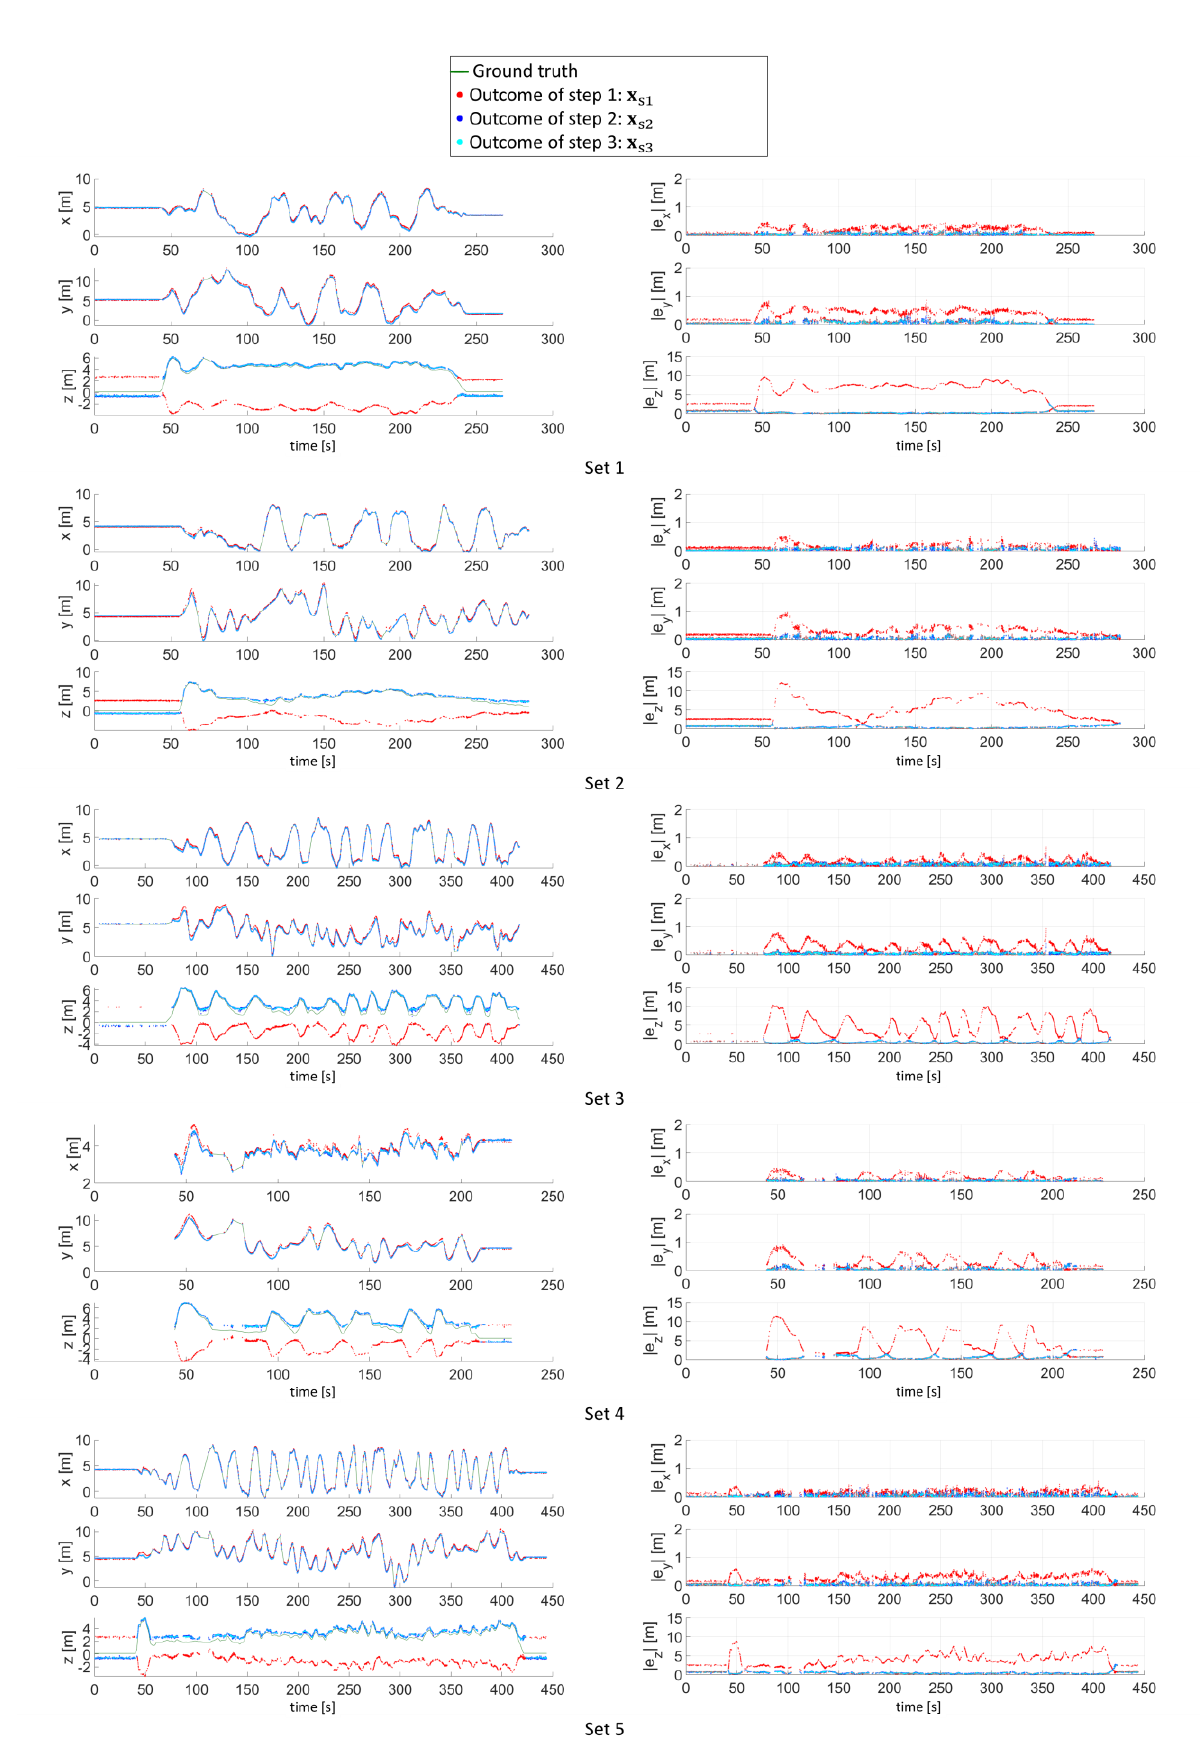
Figure 11. Ground-truth trajectory and estimated position (left column) and MAE (right column) over